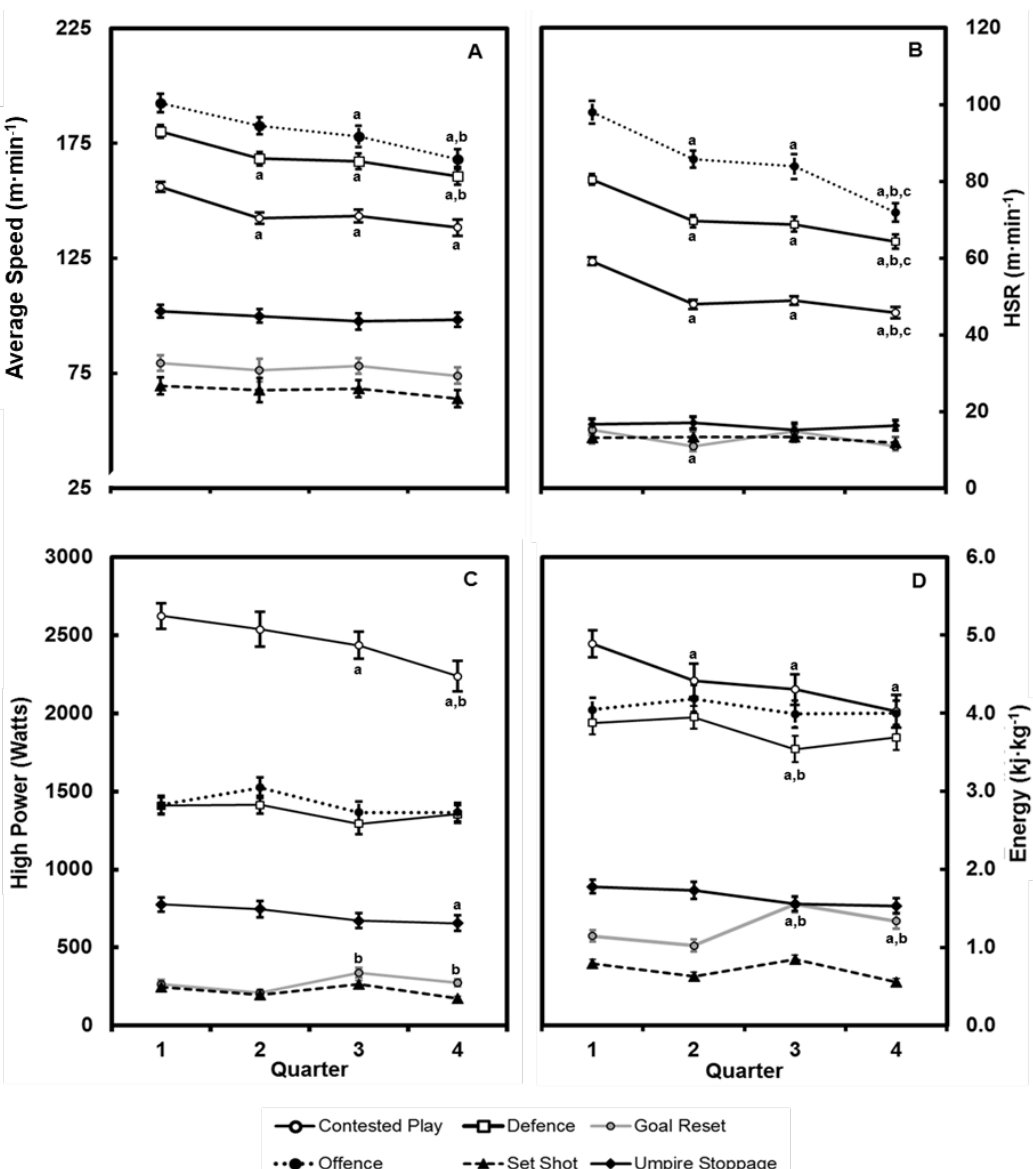
Figure 2. Match analysis by quarter for ( A ) average speed (m·min − 1 ), ( B ) high-speed running (m·min − 1 ), ( C ) high power (watts) and ( D ) energy expenditure (kj·kg ₋ 1 ) during the phases of professional Australian Football match-play. Values are mean ± 95% CI. a significantly different to quarter 1, b significantly different to quarter 2, c significantly different to quarter 3.